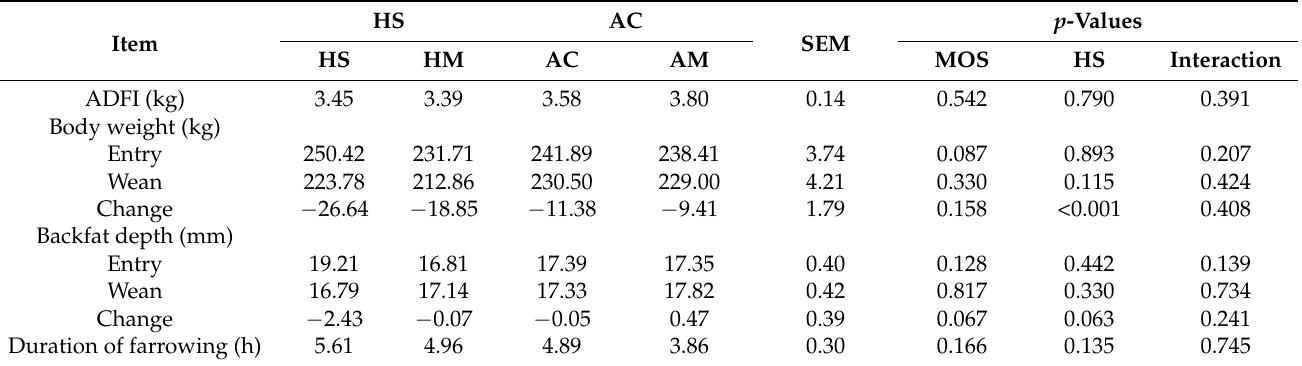
Figure 1. Temperature and humidity recordings obtained during the experiment. The environment THI ( a ), temperature ( b ), and humidity ( c ) were collected at the farm of Wuhan Jinying Animal Husbandry Co., Ltd. Data are presented as mean ± SEM. Table 2. Effects of dietary supplementation with MOS on the body condition of sows subjected to HS or